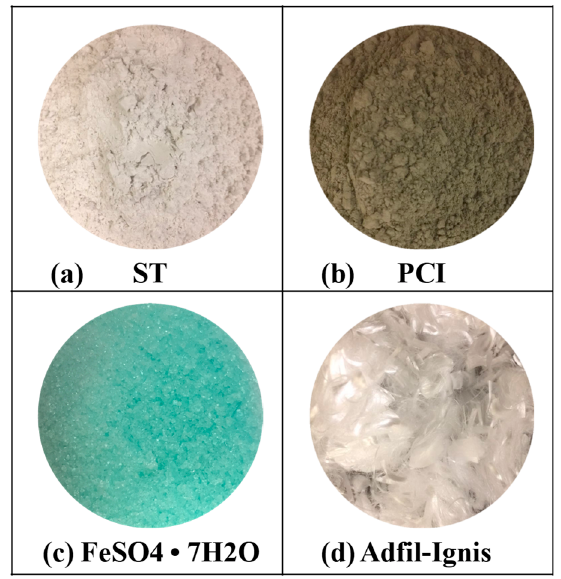
Table 2. Physical properties of the tailings.